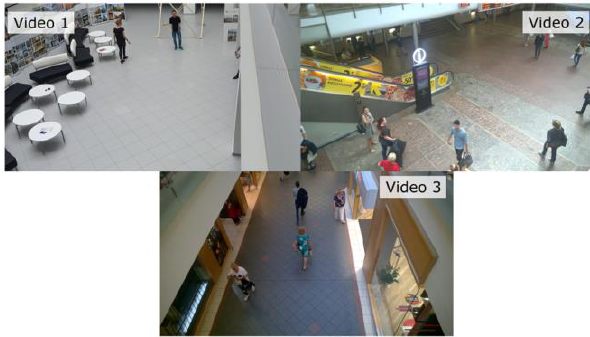
Fig. 3. Snapshots of a captured video set. Video 1 simulates anomalous behaviour in a crowd, while Video 2 and Video 3 are taken under natural conditions in crowded